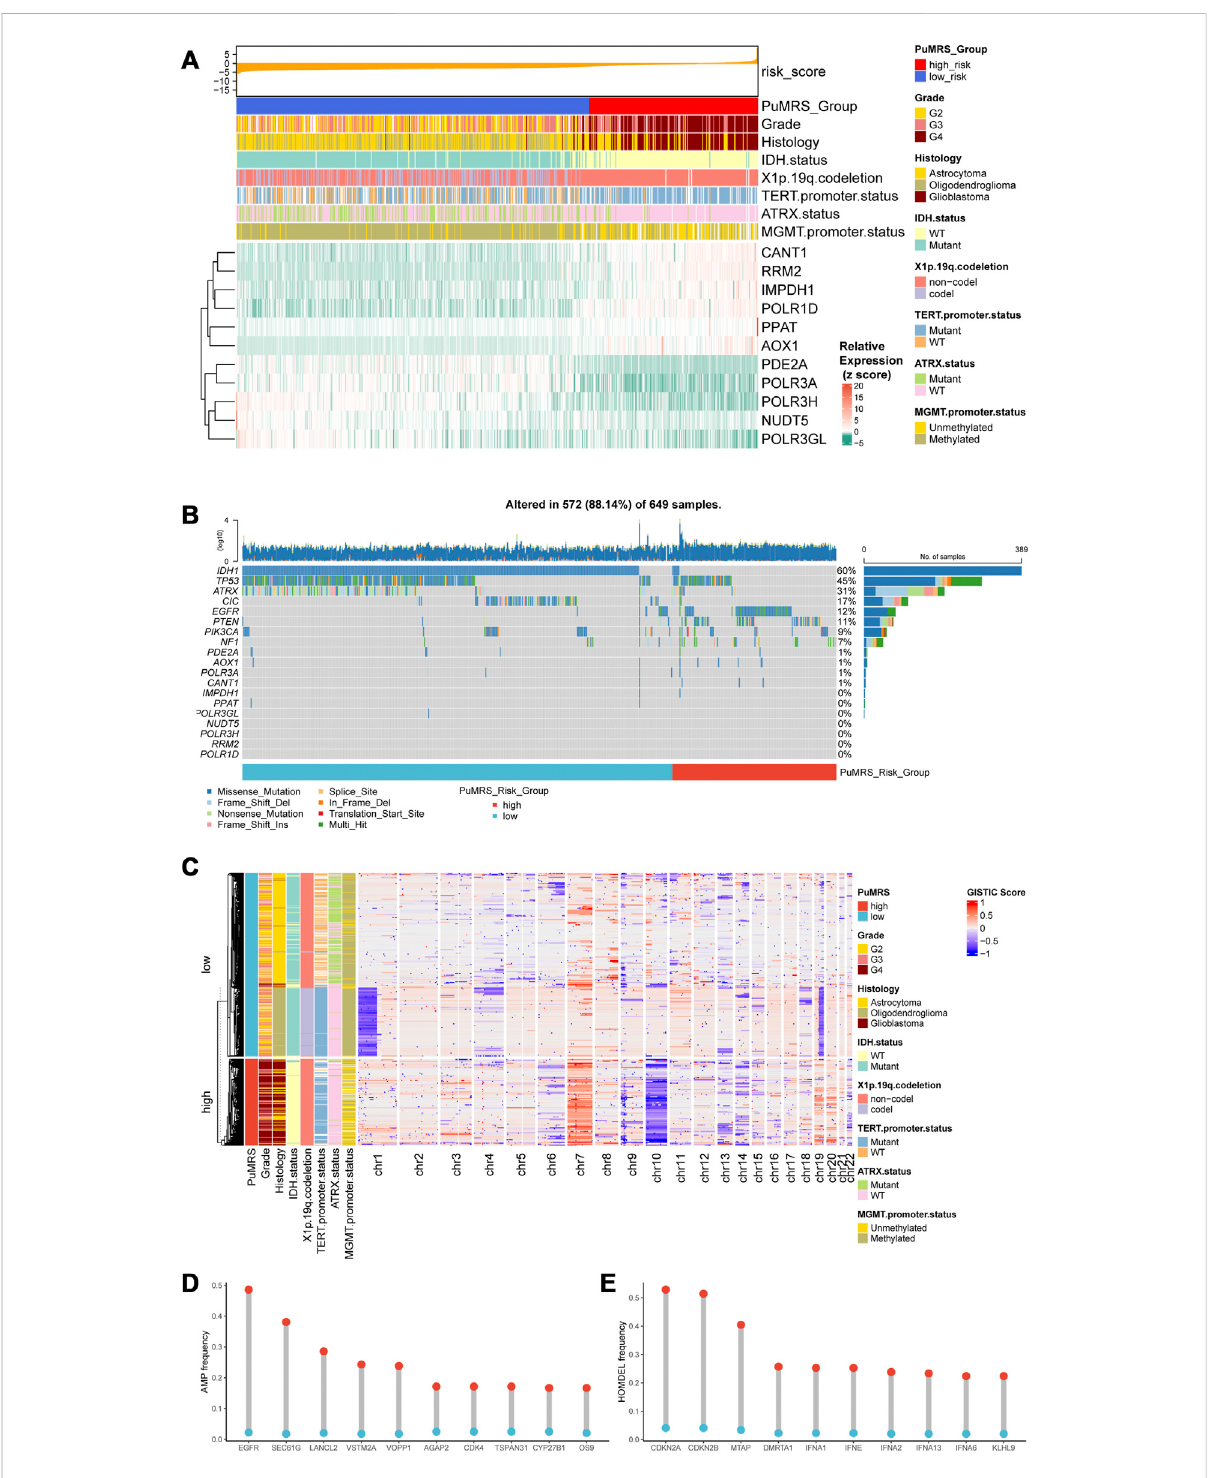
FIGURE 6 Genetic mutations andcopynumbervariationsofthetworiskgroups. (A) Expression level of11criticalPuMGsand clinicopathologicalfeatures. (B) Gene mutations of 11 critical PuMGs and top 8 frequently mutated genes. (C) Heatmap of copy number variations of the two risk groups. (D) Top 10 ampli fi cation genes in two risk groups. (E) Top 10 homozygously deleted genes in two risk